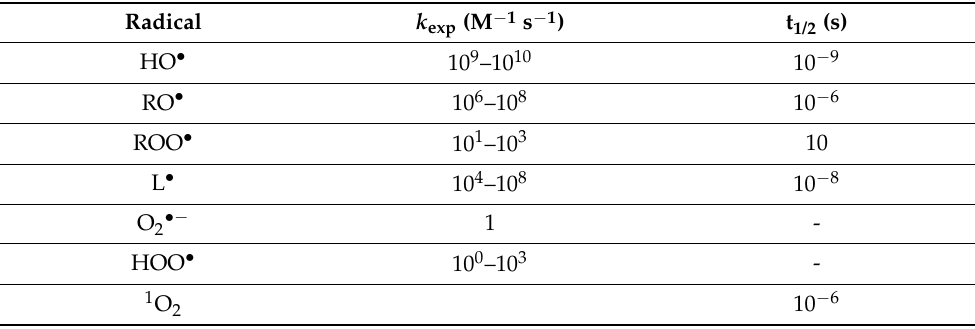
Table 2. Half-lives and typical rate constant kexp values of some ROS. L = linolenic acid. Data from ref. [8].